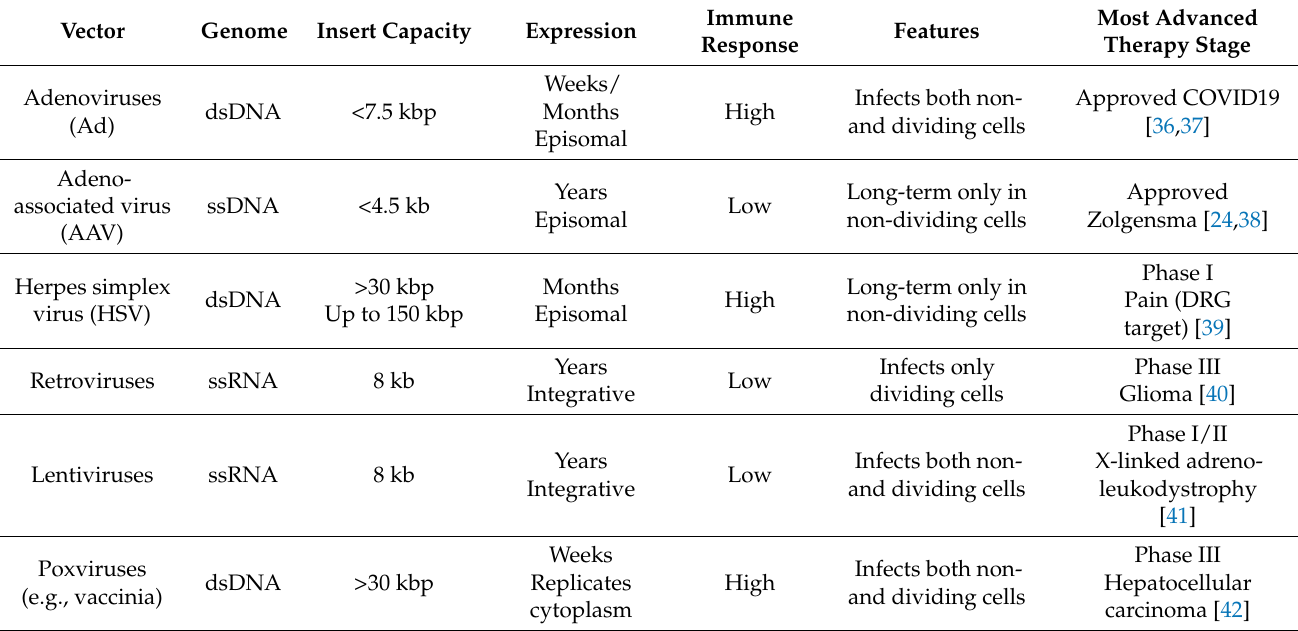
Table 1. Viral vectors in gene